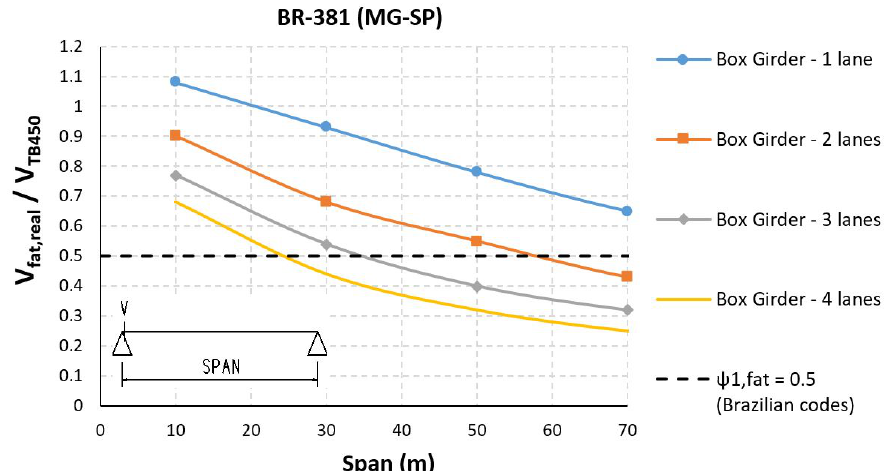
Figure 14. Bias factors for shear force at support in simply supported box-girder bridges – BR-381 (MG-SP).